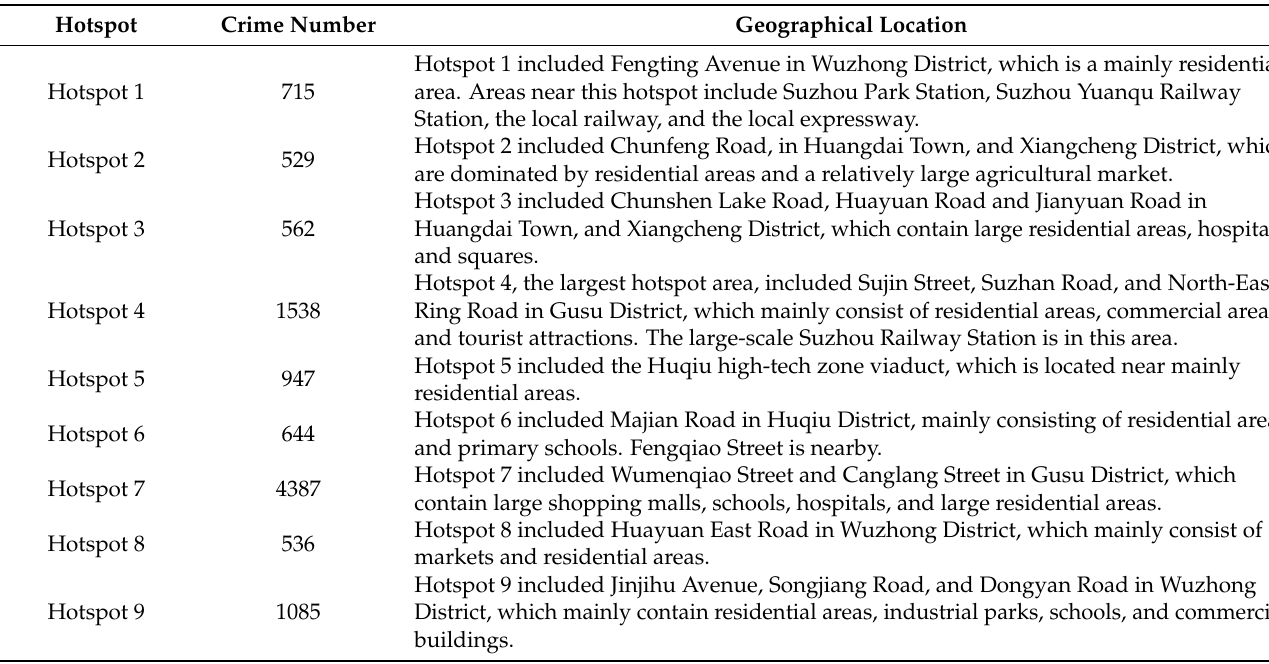
Table 2. Hotspots’ geographic